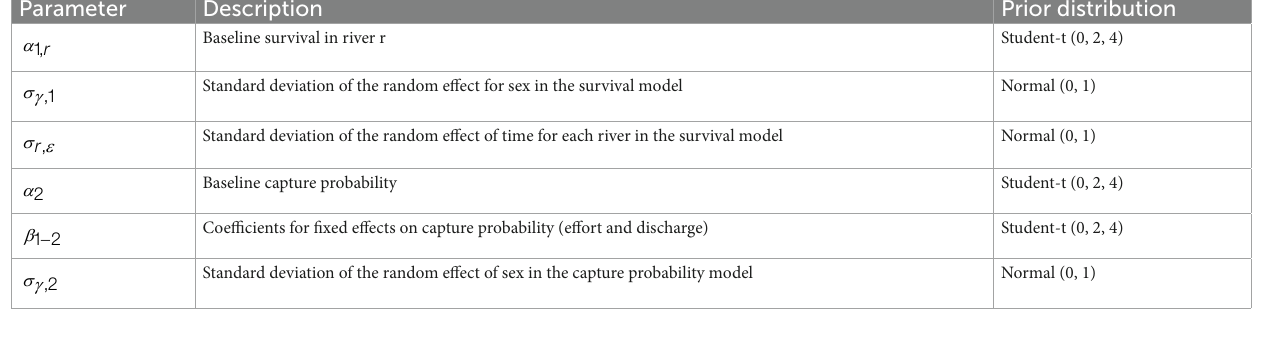
TABLE 1 Prior probability distributions for the Cormack–Jolly–Seber model.